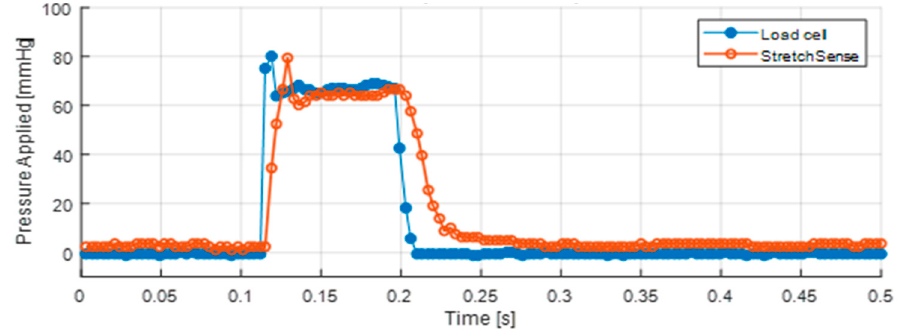
Figure 12. Dynamic response of load cell versus StretchSense sensor during one piston load.